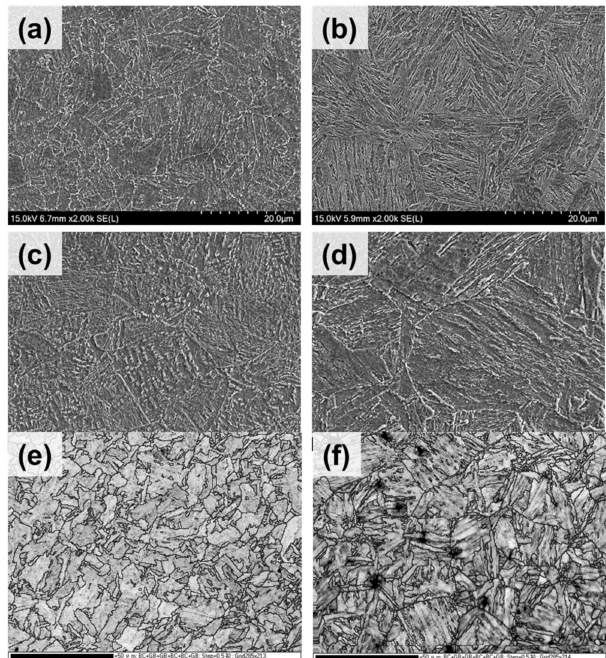
Figure 3. SEM observations ( a – d ) and EBSD image quality maps ( e , f ) of the studied steels in ( a , b ) as-quenched and ( c – f ) as-tempered conditions. ( a , c , d ) Cu-bearing age-hardening steel; ( b , d , f ) NiCr- MoV